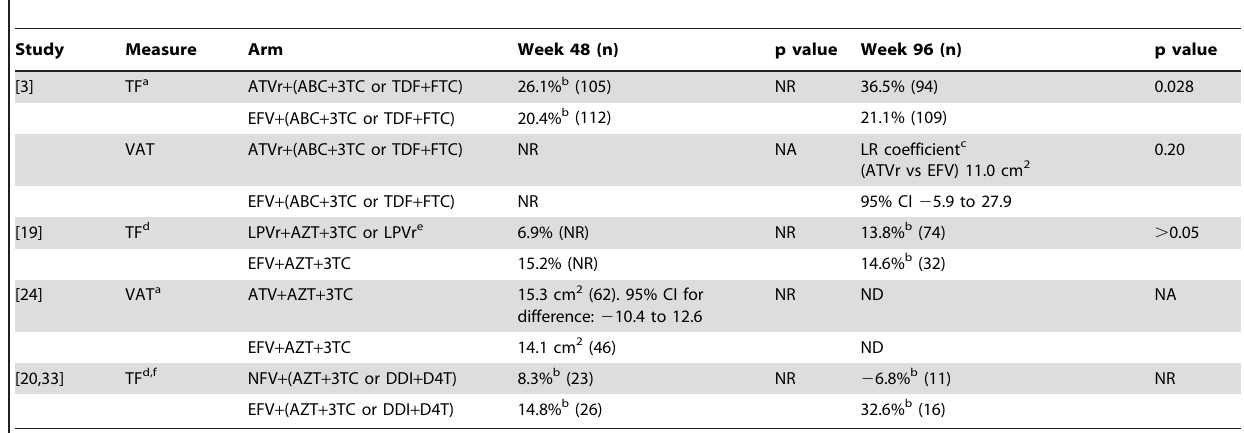
Table 13. Change from baseline in trunk fat (TF) on DEXA scan, and visceral adipose tissue (VAT) on CT scan: PI versus NNRTI.